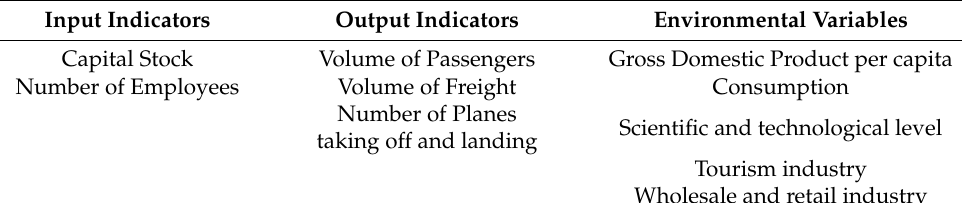
Table 1. Index system for air transport system (ATS) efficiency and productivity